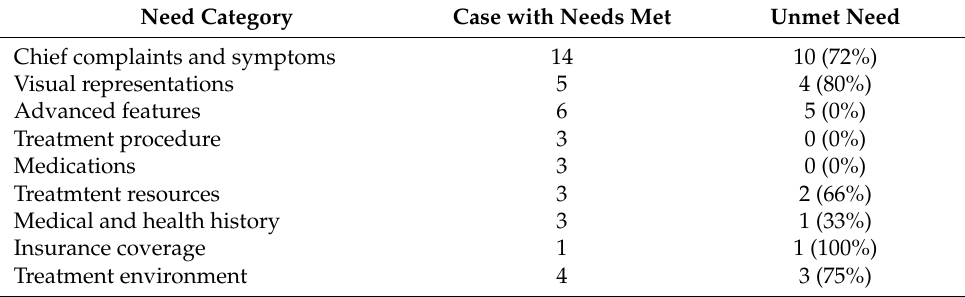
Table 1. Themes of information